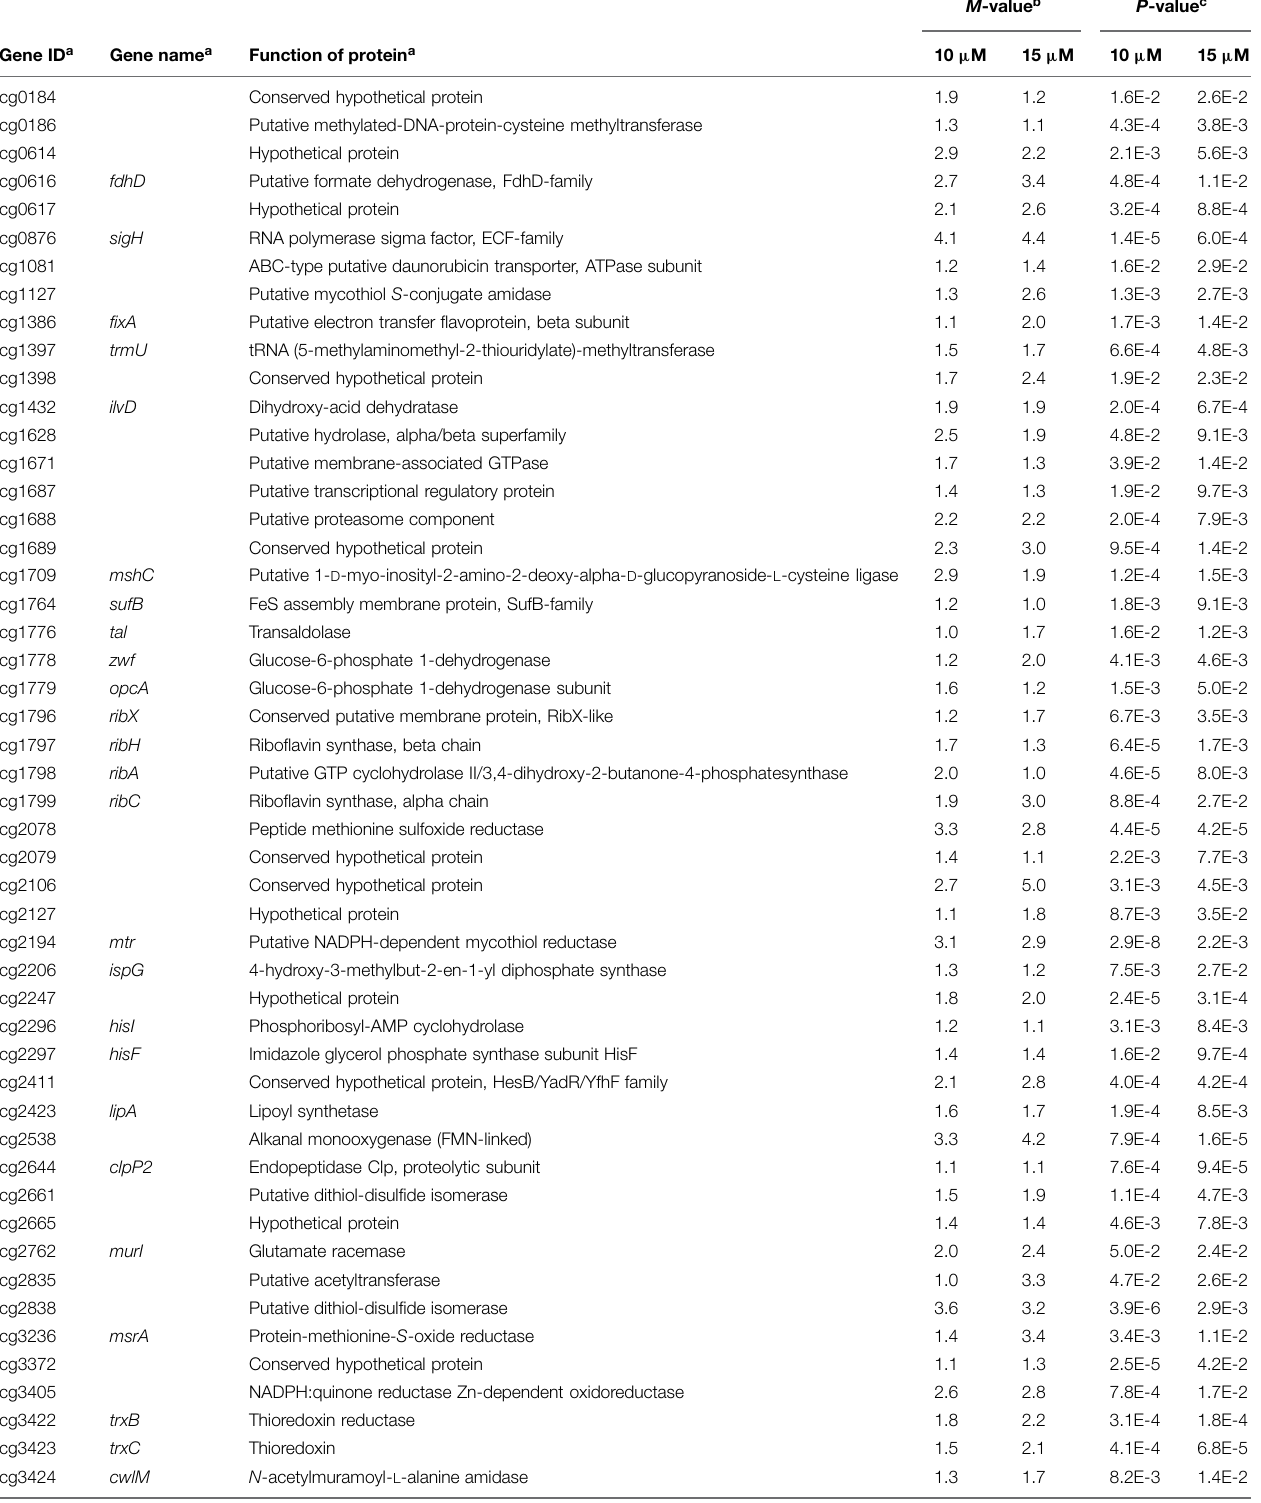
M -value b P -value